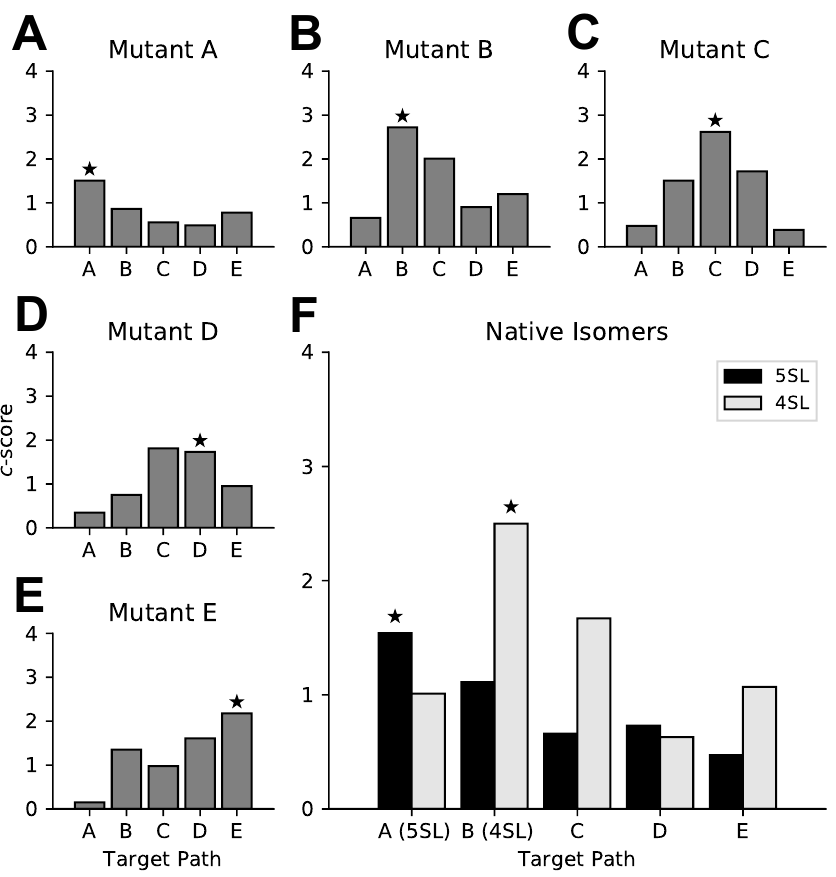
Figure 4. patteRNA scores on the Sherpa set of RRE SHAPE (selective 2 (cid:48) -hydroxyl acylation analyzed by primer extension) profiles. ( A – E ) Each panel corresponds to a SHAPE profile for an RRE mutant. Grey bars indicate patteRNA ’s c -scores for the five Paths A–E. Highlighted with a star is the score for the predicted path in the tested profile. ( F ) c -scores for the two native 5SL and 4SL isomers. Bars correspond to scores for Paths A–E on the 5SL (black) and 4SL (grey) profiles. Similar to the other panels, stars highlight scores for the predicted path in each profile, namely Path A for 5SL and Path B for 4SL. All scores correspond to the SL III/SL IV region (nt